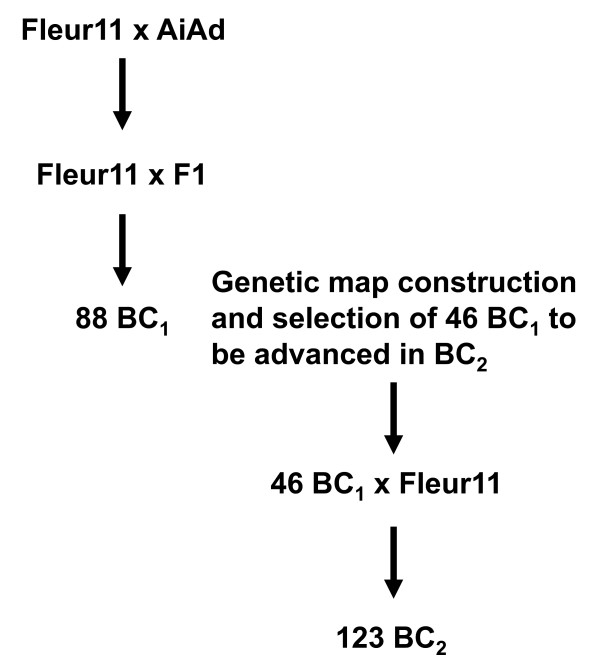
Breeding scheme used in the study. The cultivated Fleur 11 variety was used as female parent to produce the F1 and the BC1F1 individuals, and as male parent for producing the BC2F1 individuals.